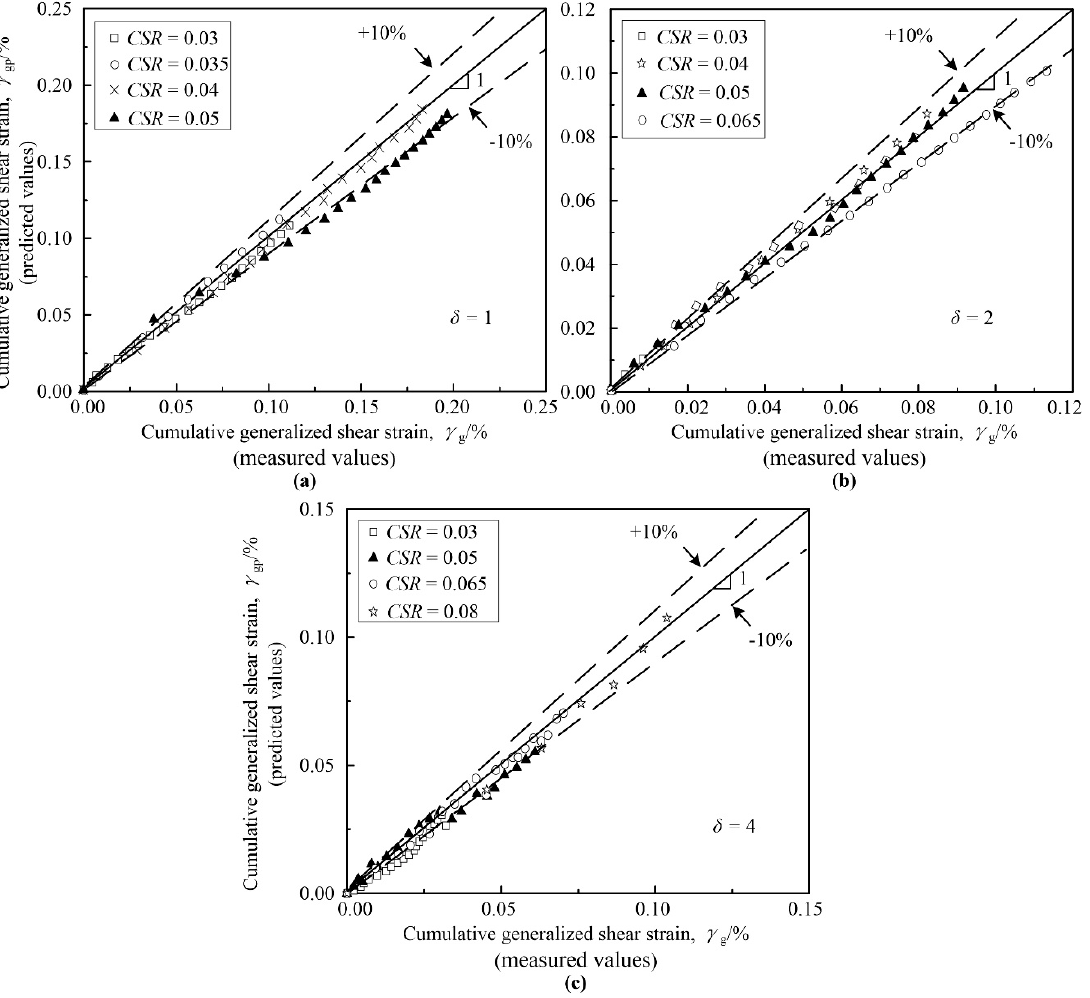
Figure 13. ( a – c ) Comparison of measured values and predicted values of cumulative generalized shear strain.